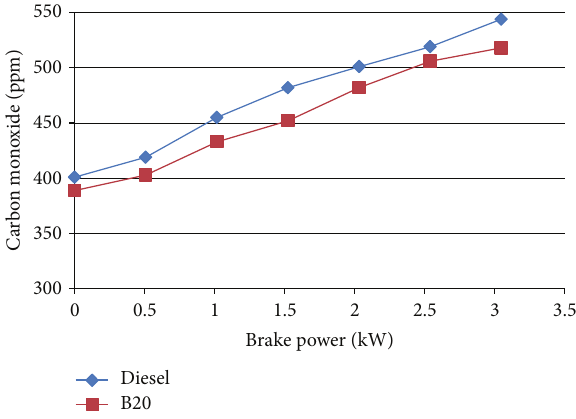
Figure 11: Carbon monoxide emission (ppm) versus brake power.